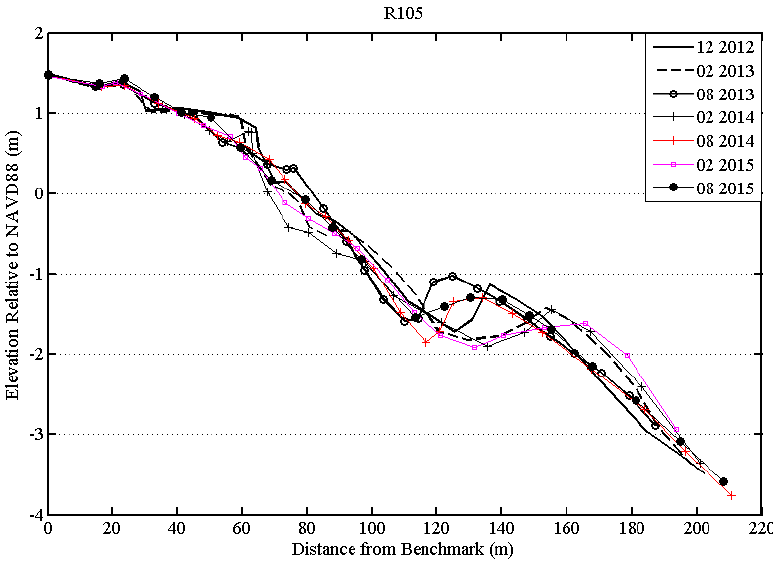
Figure 9. Example profile from North Redington Beach, R105.